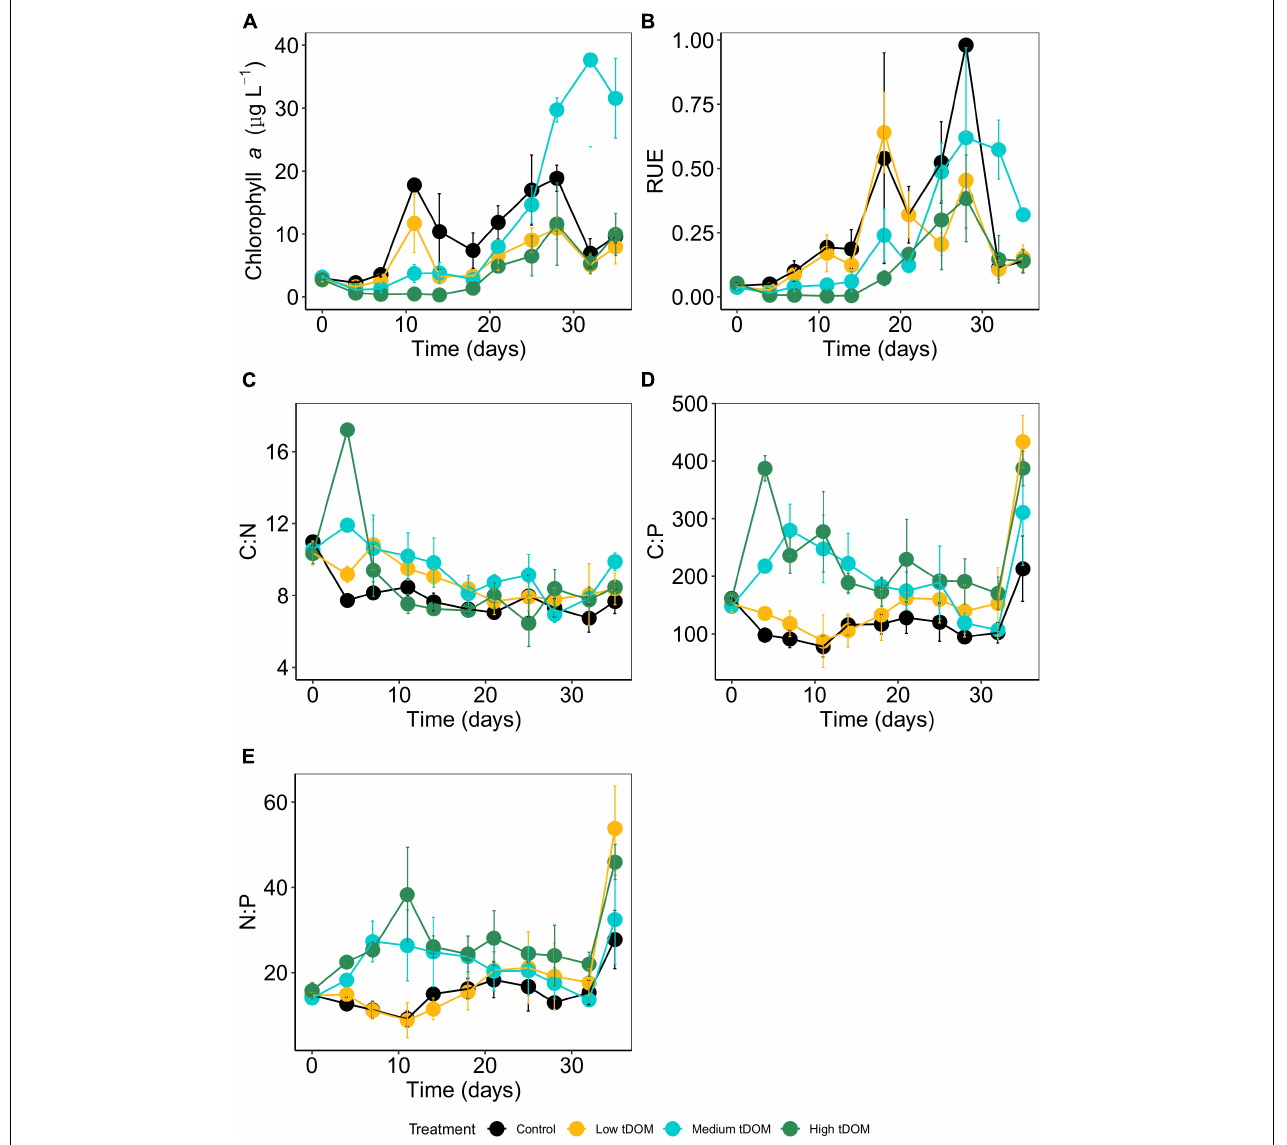
FIGURE 3 | Phytoplankton (A) biomass (Chl a in µ g L − 1 ), (B) resource use efficiency (RUE), and molar particulate (C) C:N, (D) C:P, and (E) N:P ratios over 35 days of the experiments. Data are given as mean values with standard deviation. Colors indicate treatments: control (black), low tDOM addition (yellow), medium tDOM addition (blue), and high tDOM addition